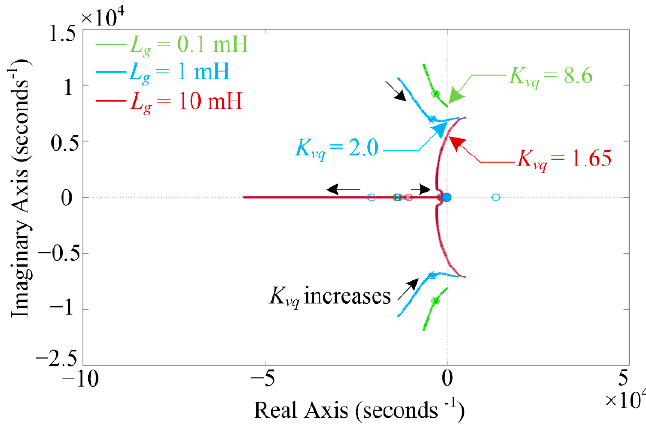
Figure 12. Root loci of G icq _cl_dr ( s